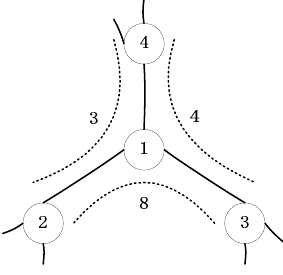
Figure 5. Analysis diagram of adding a shortcut.